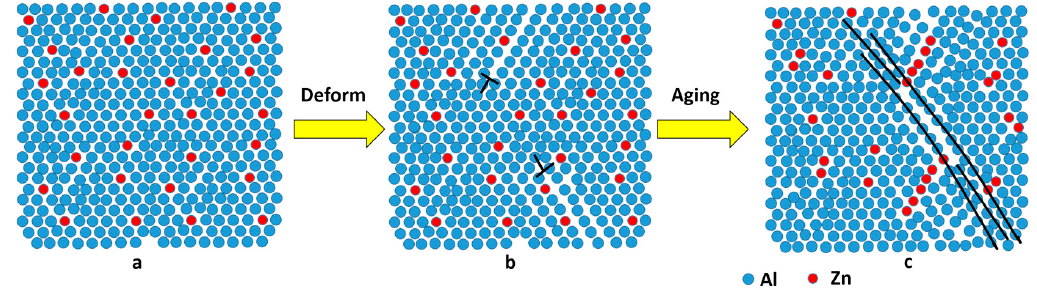
Figure 4. A schematic image showing the formation process of an intrinsic stacking fault: ( a ) atomic arrangement of solid solution state; ( b ) vacancies and dislocations induced by deformation; ( c ) a stacking fault emerges between two precipitates during aging through vacancies gathering to lower the energy.